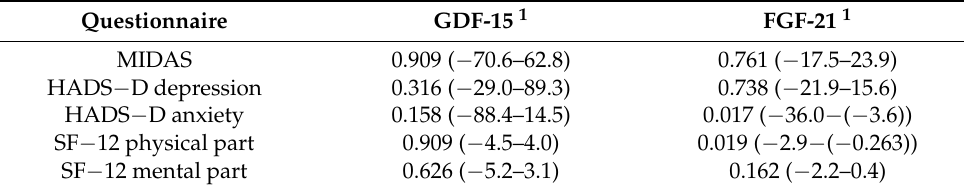
Table 4. Multiple linear regression of GDF-15 and FGF-21 concentrations depending on the results of MIDAS, HADS and SF-12 questionnaires. For the calculations, all p -values are stratified for each clinical parameter as shown in Table 3. The results are presented in a similar way to Table 3. For example, higher values in the anxiety part of HADS-D significantly correlate with a decrease of FGF- 21 between 3.6 and 36.0 pg/mL per point in HADS-D. All parameters were analyzed metrically. For interpretation, higher scores in the MIDAS and HADS sections are associated with higher impairment, while this is indicated by lower scores in the